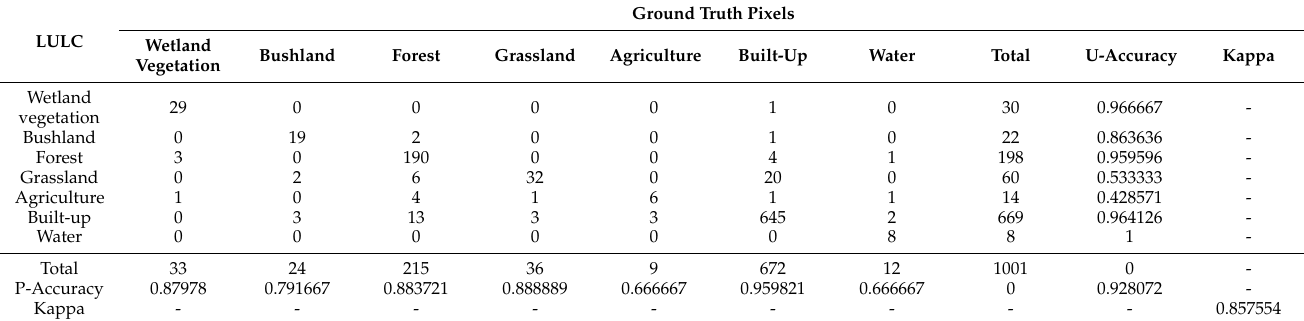
Table 5. Accuracy assessment results of LULC classification for image of